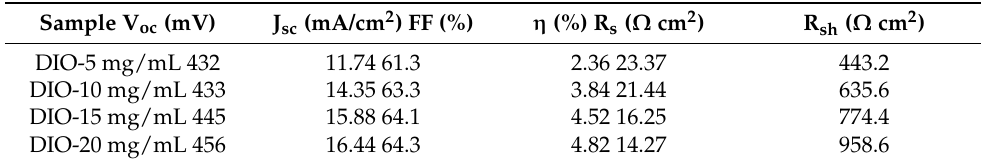
Figure 10. Current density-voltage (J–V) characteristic of a CZTS photovoltaic device, the inset shows a cross-sectional SEM micrograph of the photovoltaic. Table 2. Photovoltaic performance of the CZTS solar devices prepared using different 1,8- diiodooctane (DIO) additive